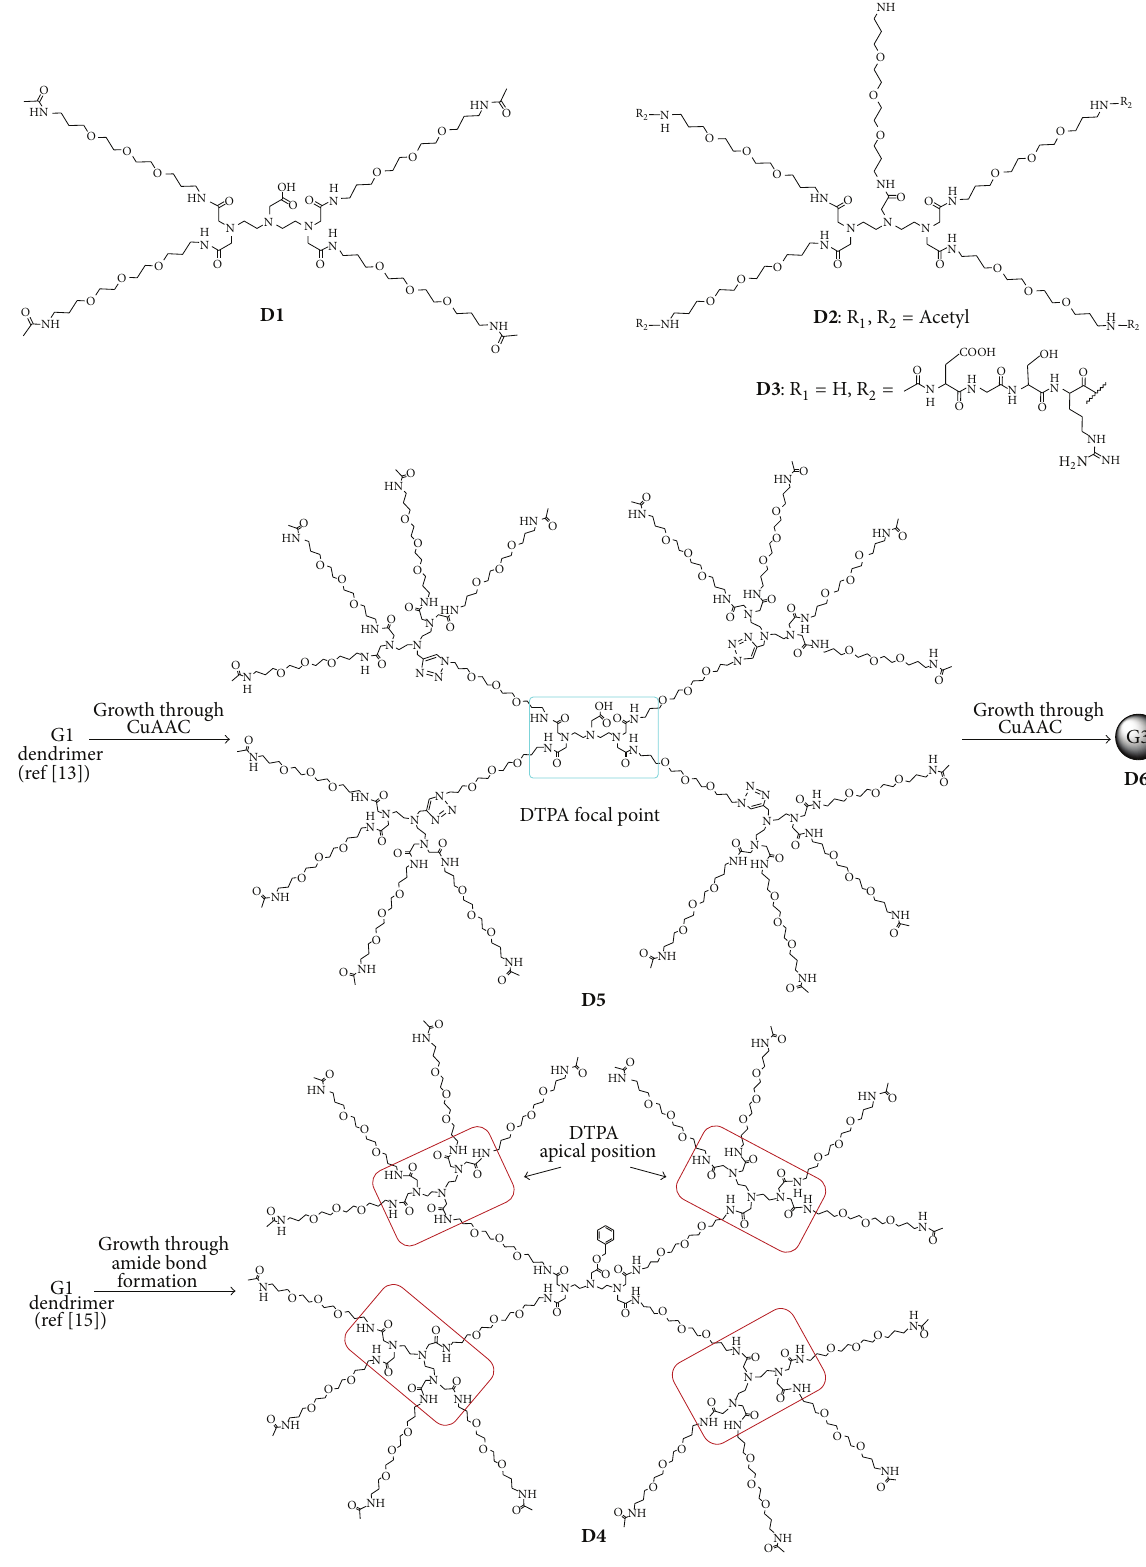
Figure 1: Molecular structures of the different OEG-DTPA dendrons used in this study. The central DTPA moiety is indicated in blue whereas the apical DTPA moieties are indicated in